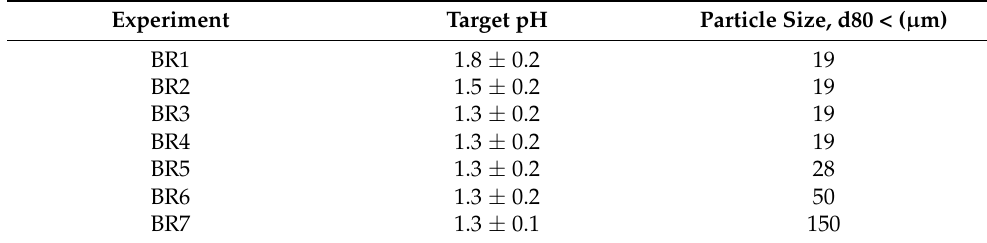
Table 2. Parameters of the bioleaching reactor (BR)